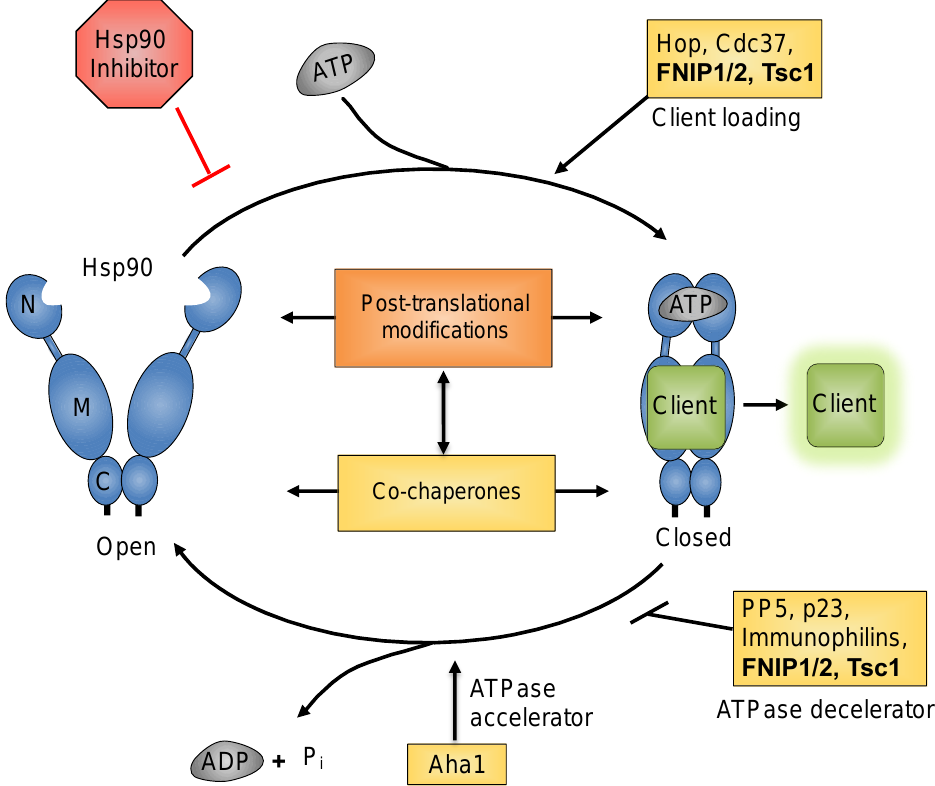
Figure 2. The Hsp90 chaperone cycle. Open Hsp90 is dimerized only through contacts in the CTD. ATP binding and an ordered series of conformational changes allow Hsp90 to adopt a closed conformation, which is N-terminally dimerized. ATP hydrolysis leads Hsp90 to return to the open conformation and begins another chaperone cycle. Throughout the chaperone cycle co-chaperones bind to Hsp90 and regulate its function. PTM of Hsp90 and PTM of co-chaperones provide further regulation of the chaperone